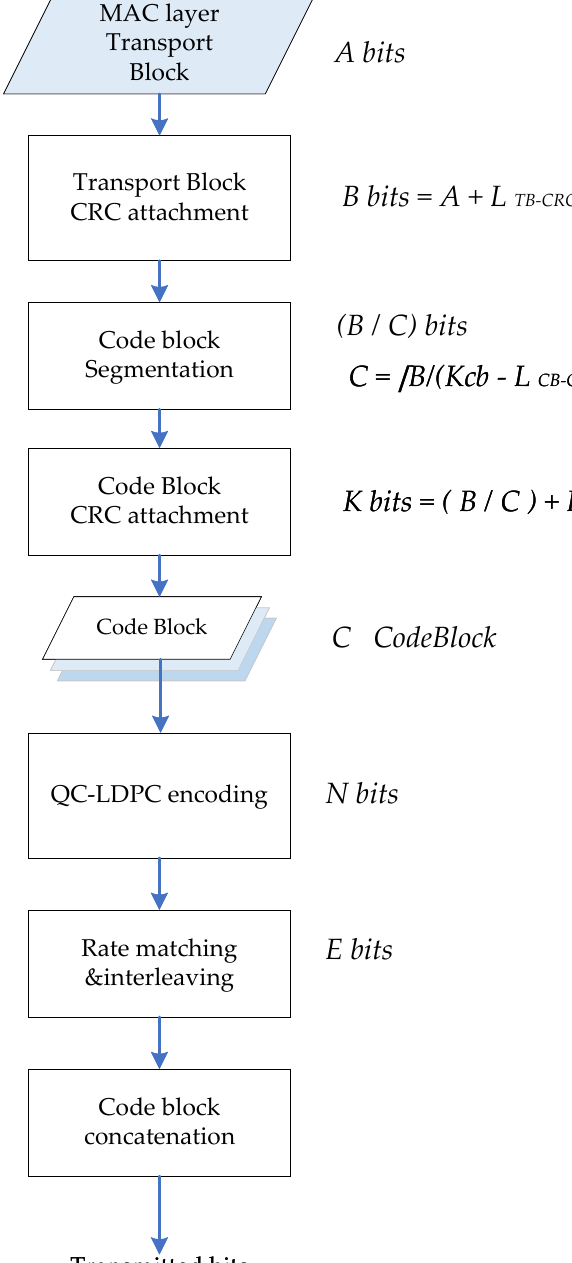
Figure 1. 5G PDSCH information transmission